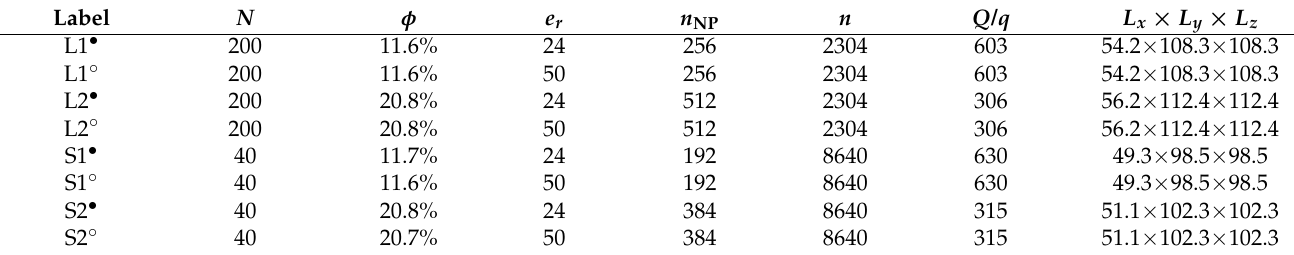
Table 1. IPNCs studied in this work. Polymerization degree N , NP volume fraction φ , relative dielectric constant ε r [43], number n NP of spherical NPs of identical radius r NP , number of polymer chains n , individual NP negative charge Q , and initial simulation box dimensions L x × L y × L z . Every 3rd polymer bead is periodically charged along the polymer backbone (including chain ends). The number of charges per polymer is n NP Q / n in each system. Each of the eight